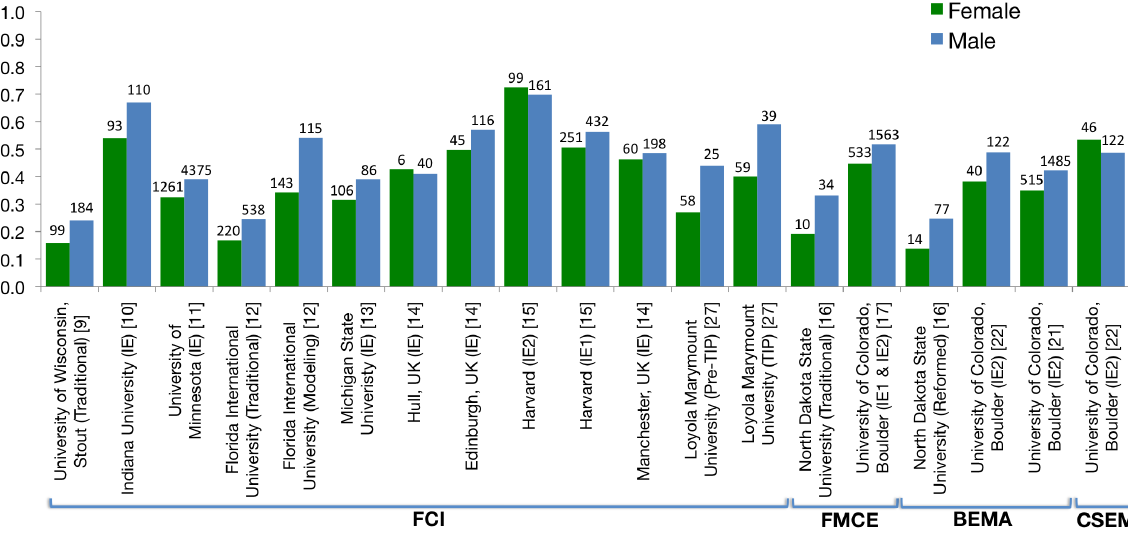
FIG. 4 (color online). Gender gap in normalized gain on the FCI, FMCE, BEMA, and CSEM across several institutions. The magnitude of male students’ normalized gain is usually greater than female students’. The average difference in normalized gain between men and women is 0.06, much smaller than the average difference in normalized gain between interactive engagement and traditional teaching methods [3]. TIP is Thinking in Physics pedagogy [27] and Pre-TIP refers to classes taught by the same instructor before the TIP teaching methods were implemented. Numbers above bars indicate the number of men and women included in the study at each